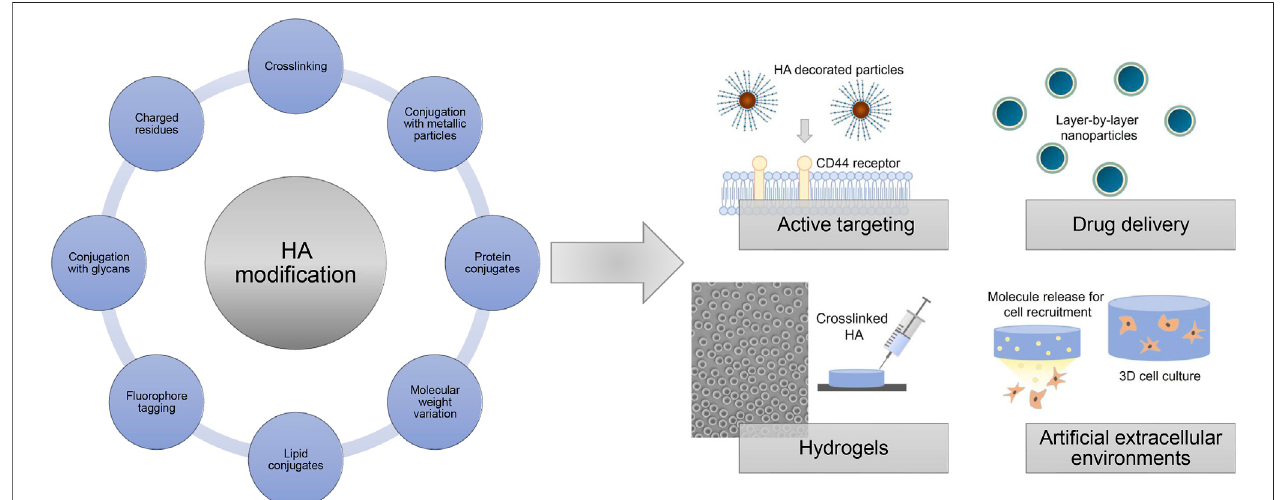
FIGURE 14 | Overview of HA modi fi cation strategies and selected